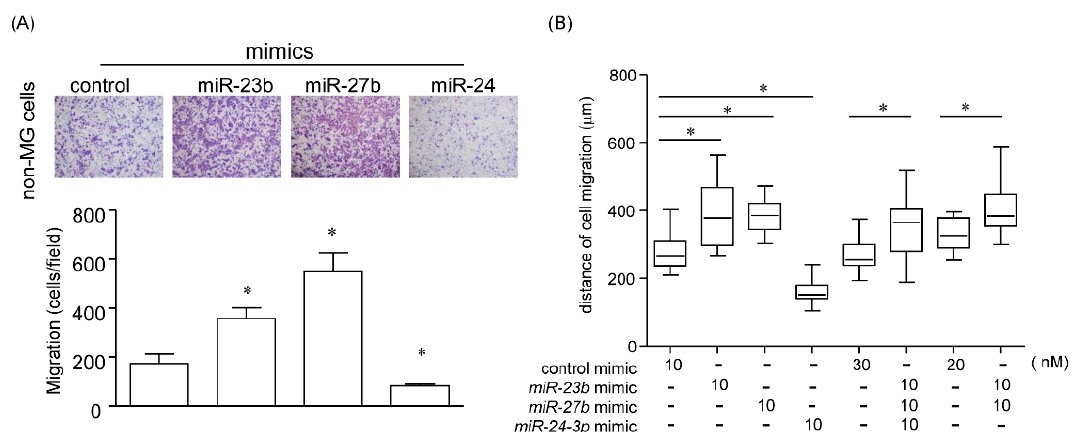
Figure 5. miR-23b and miR-27b promote cell migration. Transwell assay ( A ) and Scratch assay ( B ) were performed in non-MG cells with combinational transfection of mimic miR-23b , miR-27b , and / or miR-24 . ( A ) Upper panels show representative images of Diff-Quick staining in four experiments of transwell migration assays, and a lower graph shows quantification of cell migration expressed by cell counting. Data are expressed as the mean ± standard deviation (SD; n = 4). * Statistically significant difference versus control (unpaired Student’s t -test, p < 0.05). ( B ) After transfection with mimic miRNAs, cells were scratched. Migration distance was measured at 24 h later. Data are expressed as the mean ± standard deviation (SD; n = 4). * Statistically significant difference versus control (unpaired Student’s t -test, p < 0.05).